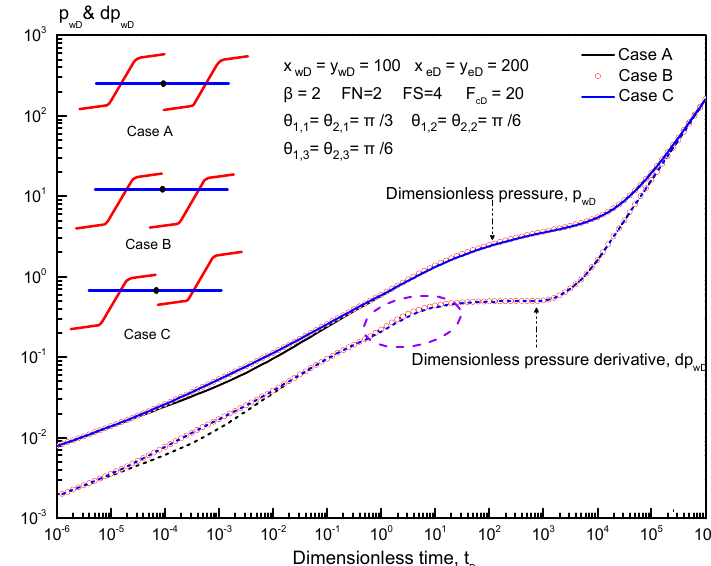
Figure 19. E ff ect of complex fracture configuration under small dimensionless fracture spacing on pressure and the pressure derivative (FS = 4).